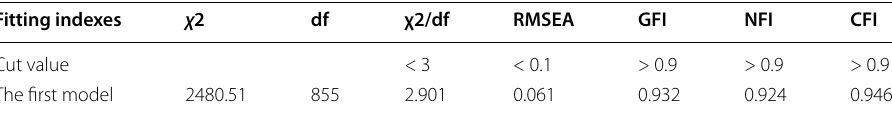
Table 3 Model fit indices (model